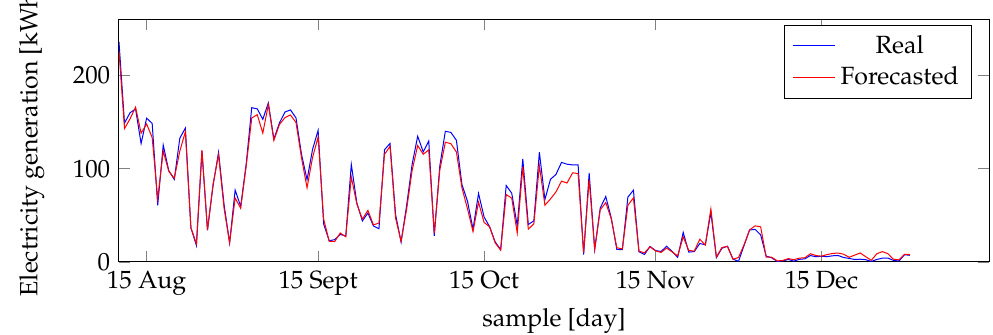
Figure 6. Forecasting results for 10 August to 31 December 2021 using